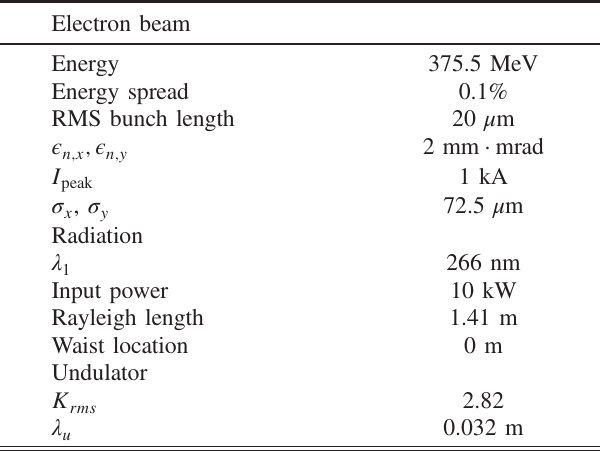
TABLE I. Parameters for the 266 nm FEL amplifier